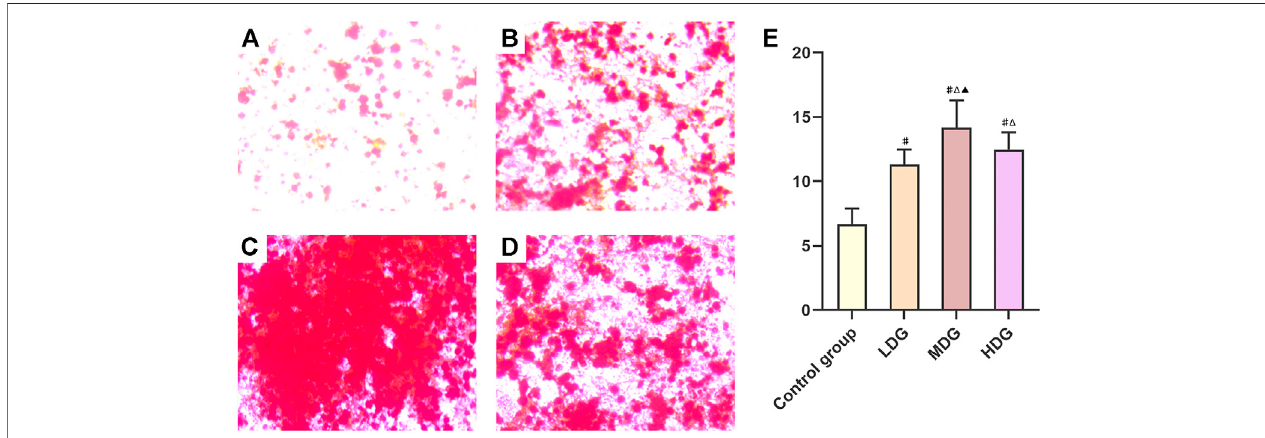
FIGURE 8 | Representative images of BMSCs with the alizarin red staining to determine the mineralized nodules. (A) Control group; (B) TFDR low dosage group; (C) TFDR medium dosage group; (D) TFDR high dosage group; (E) The mineralized nodules at each time point of the control group, TFDR low dosage group, TFDR medium dosage group, and TFDR high dosage group were evaluated. The data are expressed as the mean ± SEM of three independent experiments. # p < 0.05 vs. control group, Δ p < 0.05 vs. TFDR low dosage group, ▲ p < 0.05 vs. TFDR high dosage group.